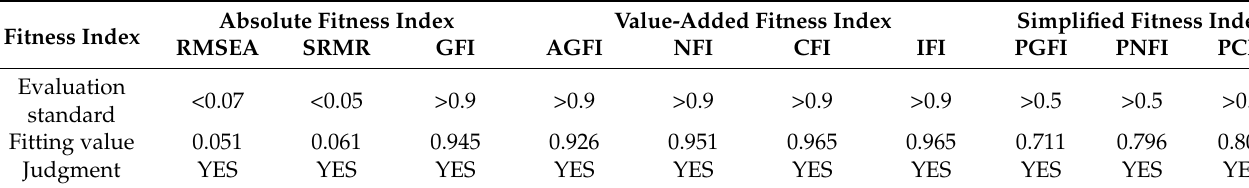
Table 6. Model fitness test (n = 901).